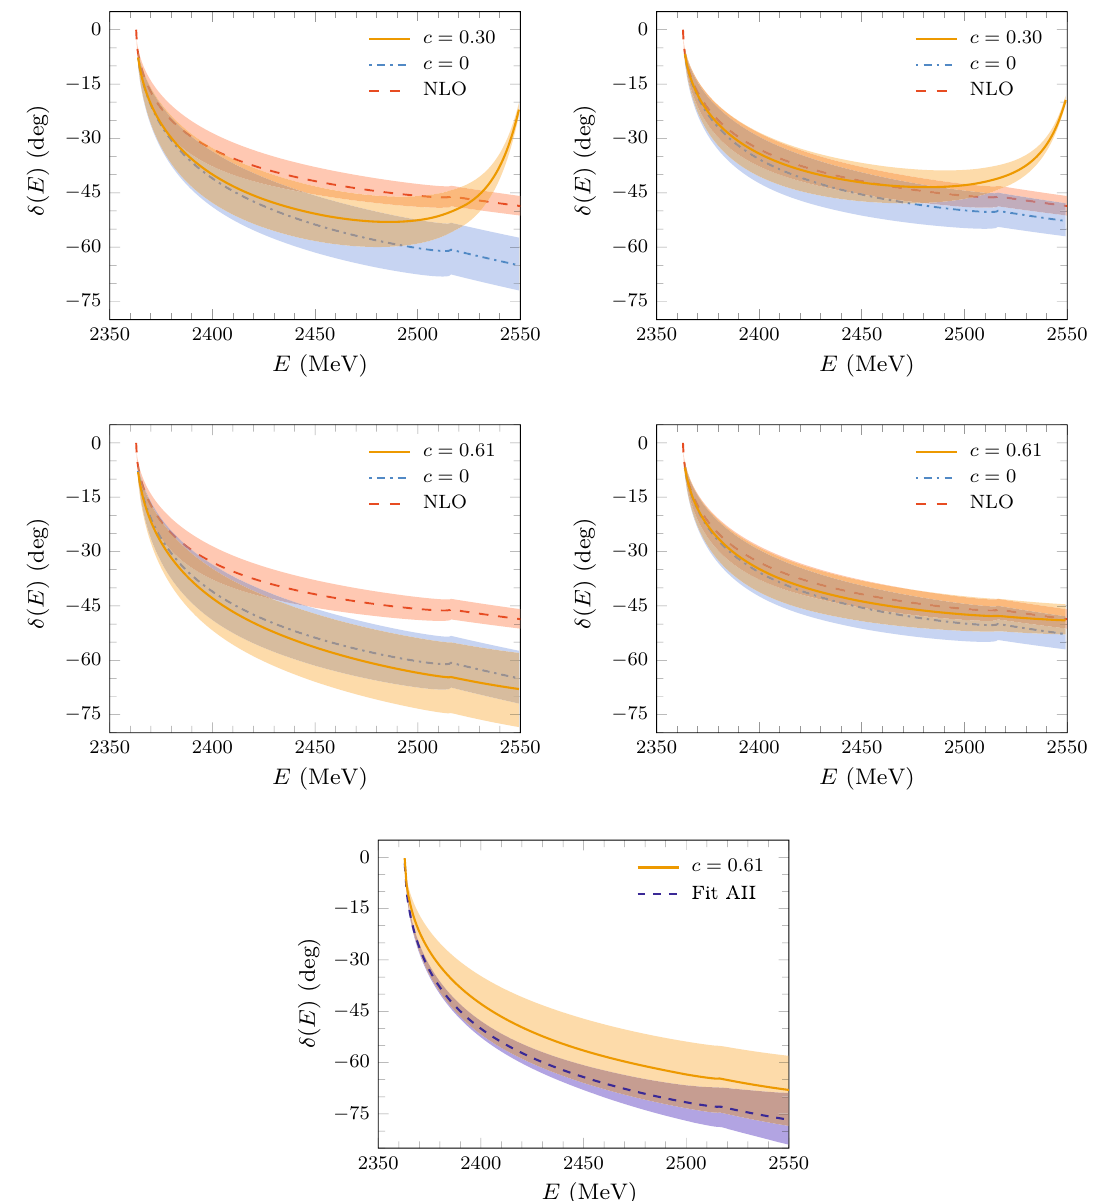
Fig. 5 First two rows of plots: energy dependence of the DK S- wave phase shifts obtained using the chiral unitarized approach of Refs. [48,49] (NLO) compared with the results deduced including the exchange of a CQM state of mass 2511 MeV (Set A). Predictions for three different values of the dimensionless LEC c , that controls the strength of the coupling of the bare CQM meson and the P φ -pair, are depicted. Note that in the case c = 0, the approach reduces to the uni- tarized LO HMChPT approach followed in [61] for the bottom-strange sector, except that in this latter case the ¯ B s η channel was not consid- ered. In the left (right) panels the UV divergences, that appear in the unitarization of the LO HMChPT+CQM amplitudes, have been renor- malized using a Gaussian cutoff (subtraction constant). For details see Tables 5 and 6. The UV behaviour of the NLO unitarized amplitudes